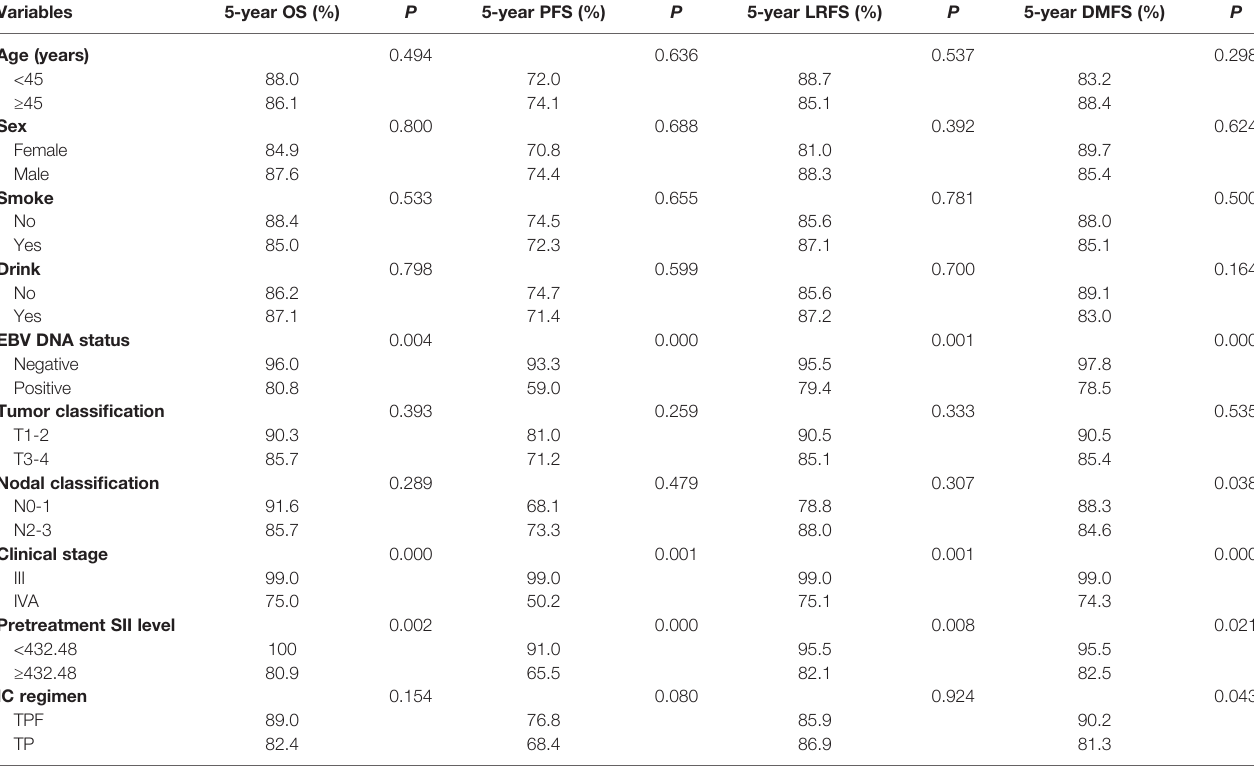
TABLE 2 | Univariate analysis of prognostic factors for LA-NPC patients.